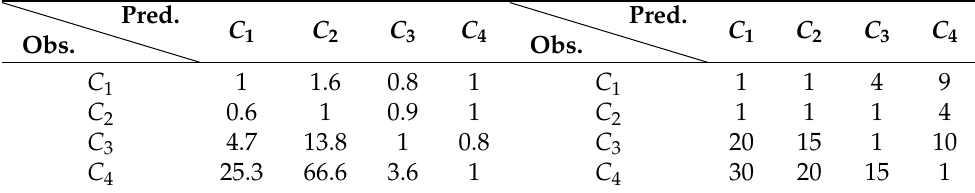
Table 4. The two custom loss matrices, CLM 1 (left) and CLM 2 (right), used for variable selection in the problem of forecasting the next-hour national air quality index (NAQI) value.